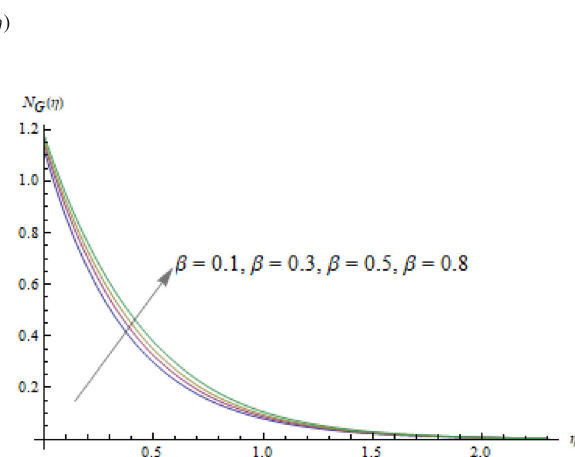
Fig. 33 Impact of β on N G